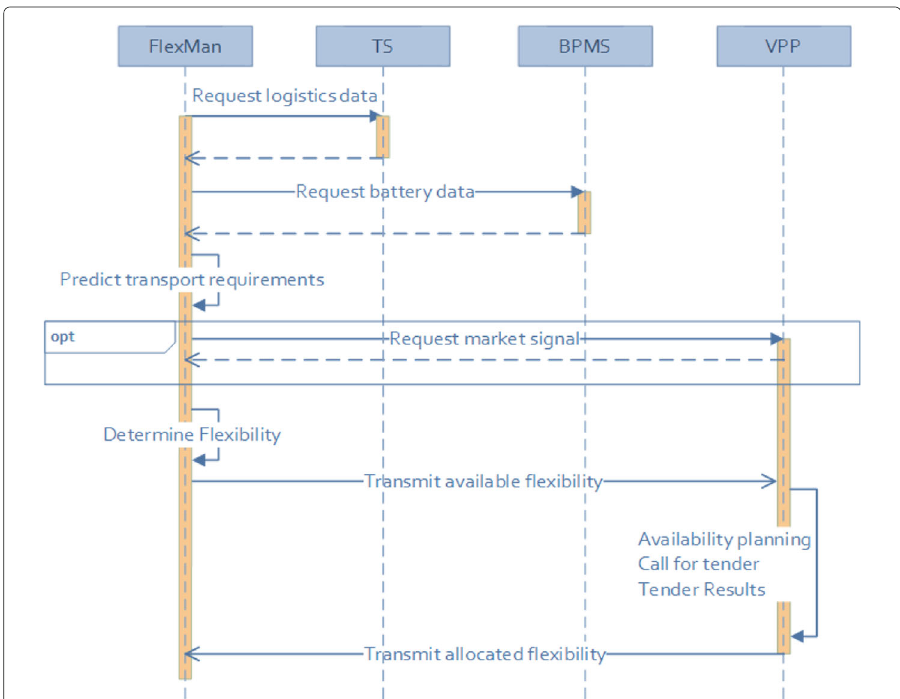
Fig. 4 Sequence diagram of day-ahead planning